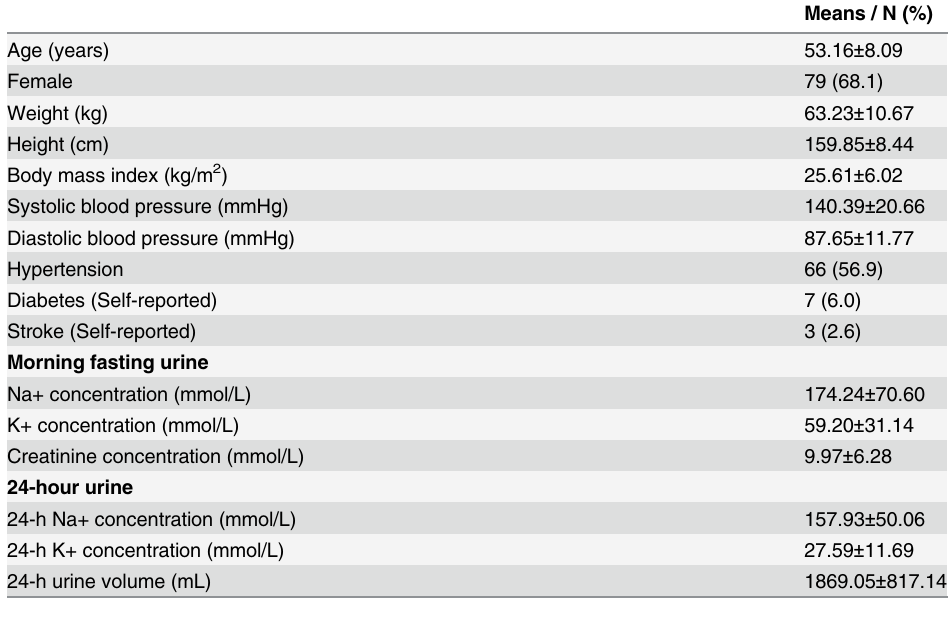
Table 2. Characteristic of participants (n = 116).